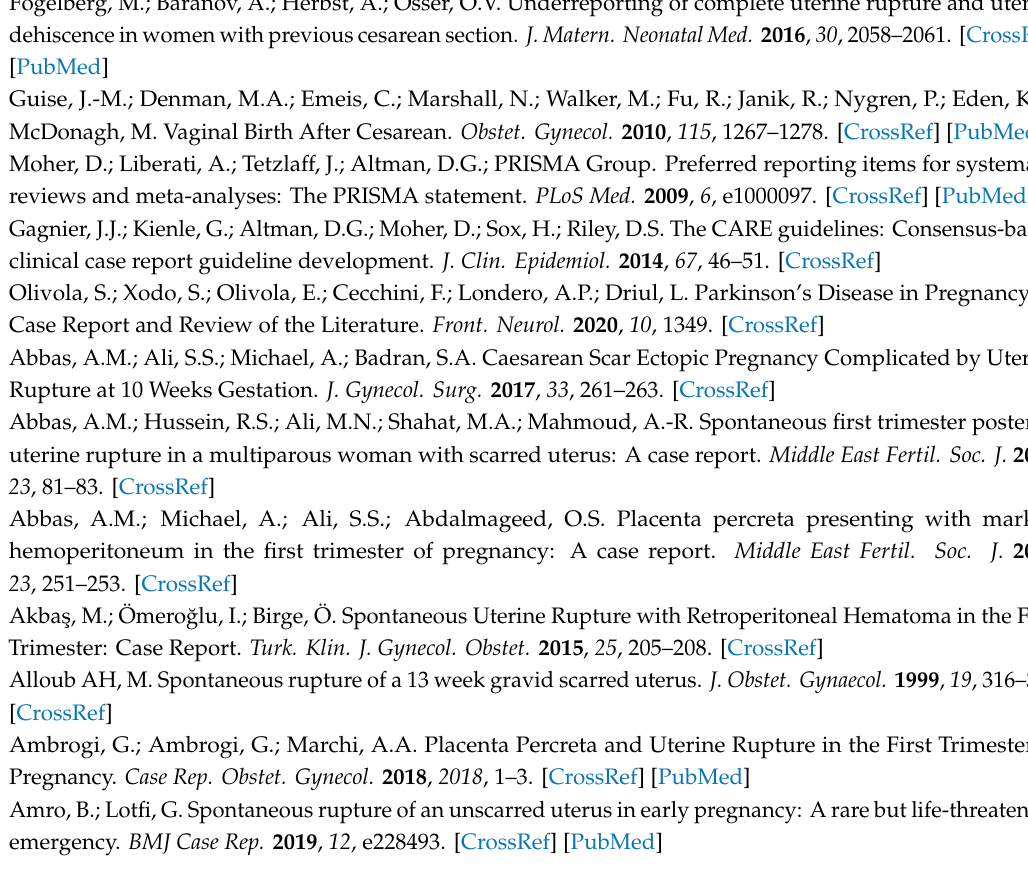
Figure S1: methodological quality analysis, Figure S2: methodological quality analysis, Table S1: Systematic review aims, Table S2: Summary of database queries, Table S3: Maternal features and previous surgery, Table S4: Management of first trimester uterine rupture cases, Table S5: Associated factors with first trimester uterine rupture and histological findings, List S1: Included and excluded studies with reason for exclusion. Author Contributions: Substantial contributions to conception and design or acquisition of data or to